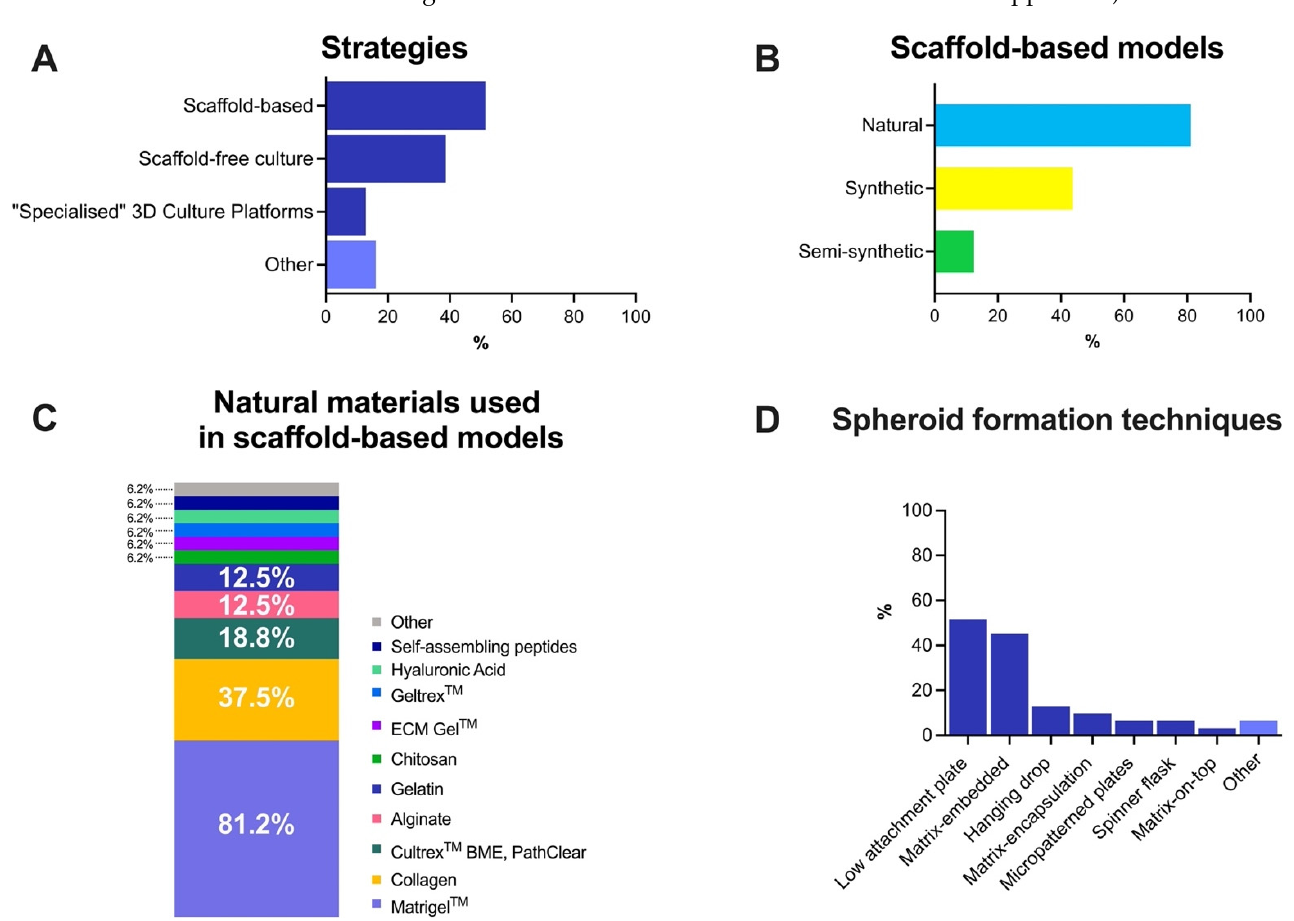
Figure 5. Overview of 3D culture models in cancer research. ( A ) Main strategies used for 3D models; ( B ) Types of scaffold- based models used in cancer research; ( C ) The most used natural materials in scaffold-based models; ( D ) Procedures used for spheroid formation. Note: some respondents indicated that they used more than one strategy, scaffold-based model type and/or spheroid formation technique. Results are represented as percentages (%).